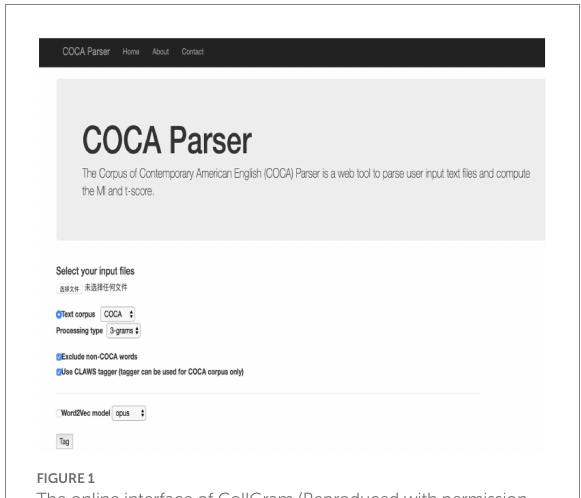
FIGURE 1 The online interface of CollGram (Reproduced with permission from Wołk et al.,